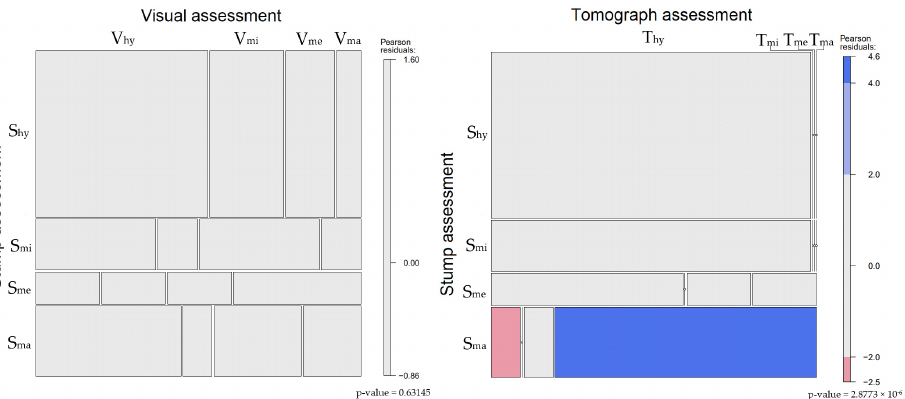
Figure 4. Classification of sample trees according to decay assessment method and the association between the results obtained using the various methods: ( left ) comparison between the visual assessment and stump assessment; ( right ) comparison between the tomograph assessment and stump assessment. Blue color indicates that there are more observations in the cell than would be expected under the null model (independence). Red means that the cells show less than the expected frequency of observations [52]. Acronym explanations are given in the materials and methods chapter.